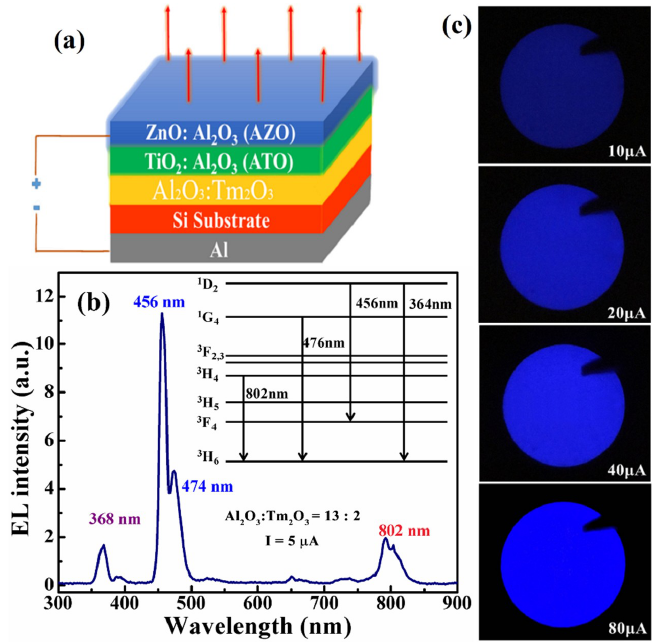
Figure 2. ( a ) The schematic for the luminescent devices based on the nanolaminate Al 2 O 3 /Tm 2 O 3 films. ( b ) The EL spectrum from the device in which the Al 2 O 3 /Tm 2 O 3 subcycle ratio is 13:2 (AOT-2), the inset shows the radiative transitions in the Tm 3+ ions resulting in the EL emissions. ( c ) The images taken by a digital camera from this AOT-2 MOS-structured light-emitting device (MOSLED) at different injection